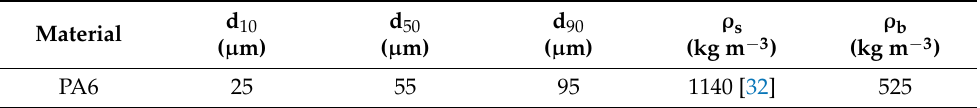
Table 1. Material properties of PA6 powder to be used in the simulation: d 10 , d 50 and d 90 are the particle diameters corresponding to the 10th, 50th and 90th percentile of the cumulative particle size, respectively; ρ s is the density of the solid; ρ b is the bulk density of the powder. Value with reference was taken from the literature, the other values were taken from the technical data sheet of the powder.